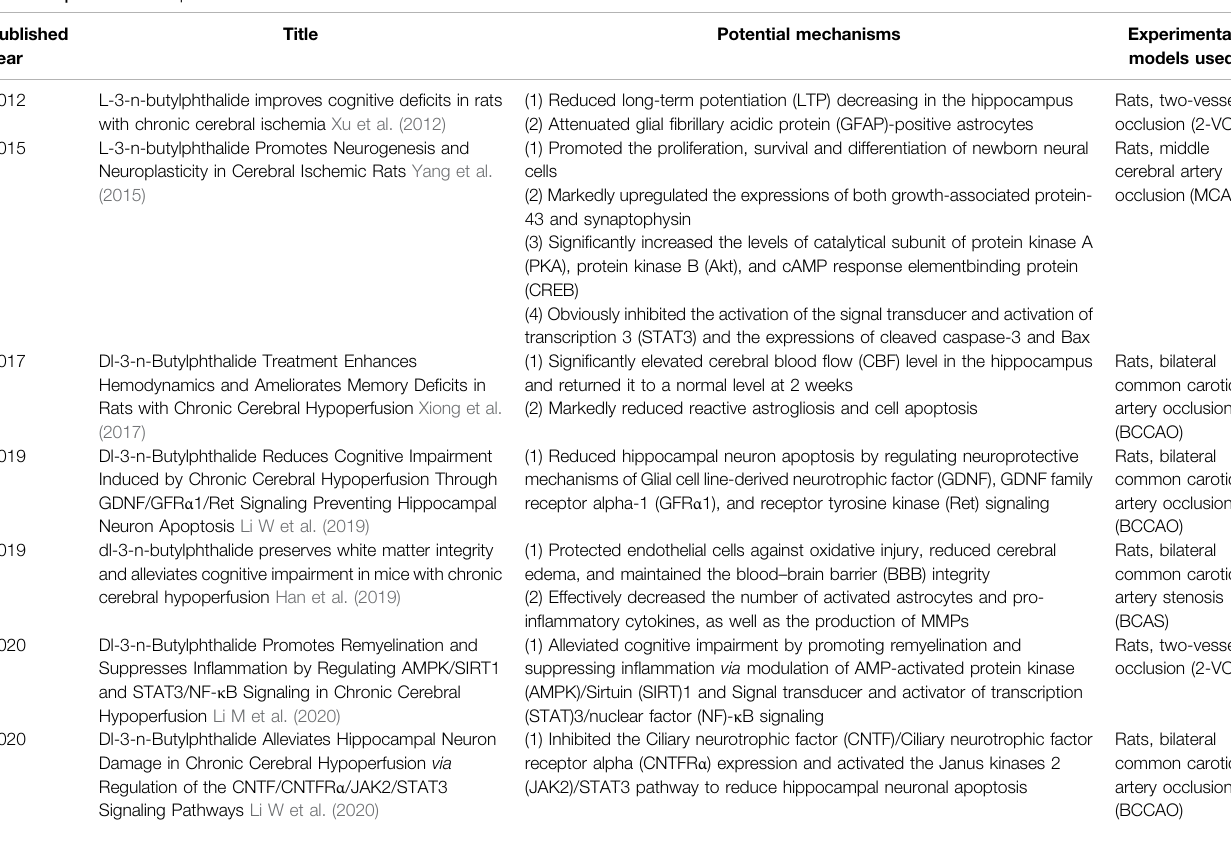
TABLE 4 | Possible therapeutic mechanisms of